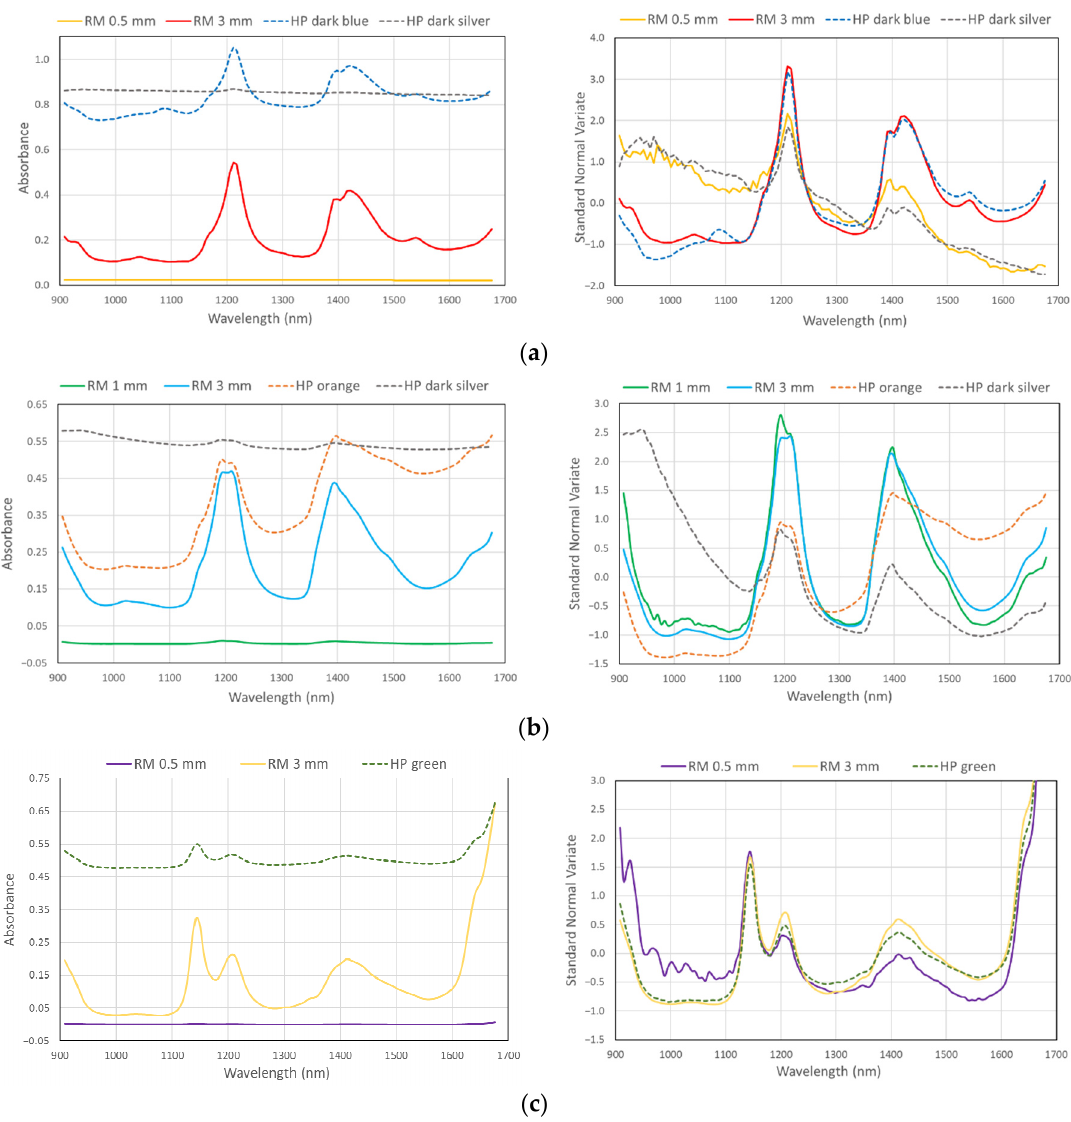
Figure 6. Raw spectra (left) and processed spectra (SNV, right) of di ff erent size reference material (RM) and colored household plastic samples (HP), examples for HDPE ( a ), PP ( b ), and PS ( c